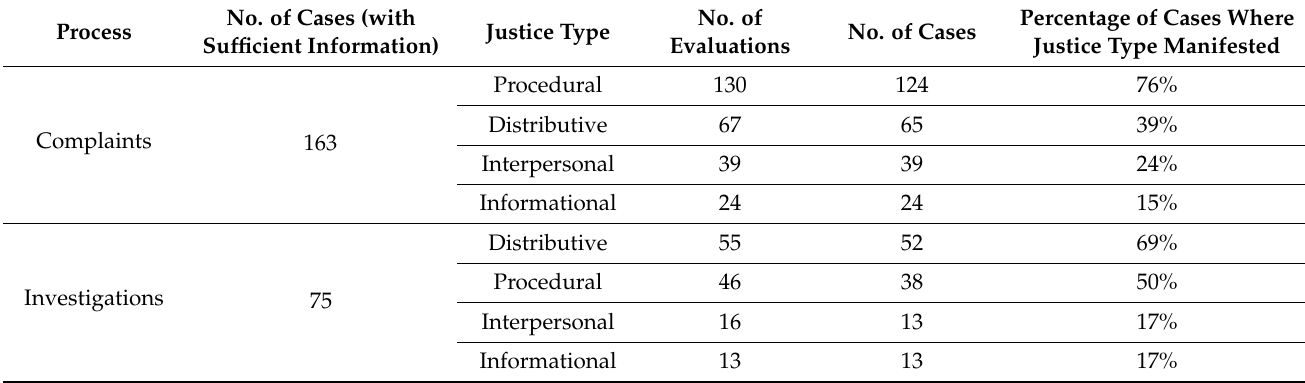
Table 5. Percentage of Cases Represented by Violations to Justice